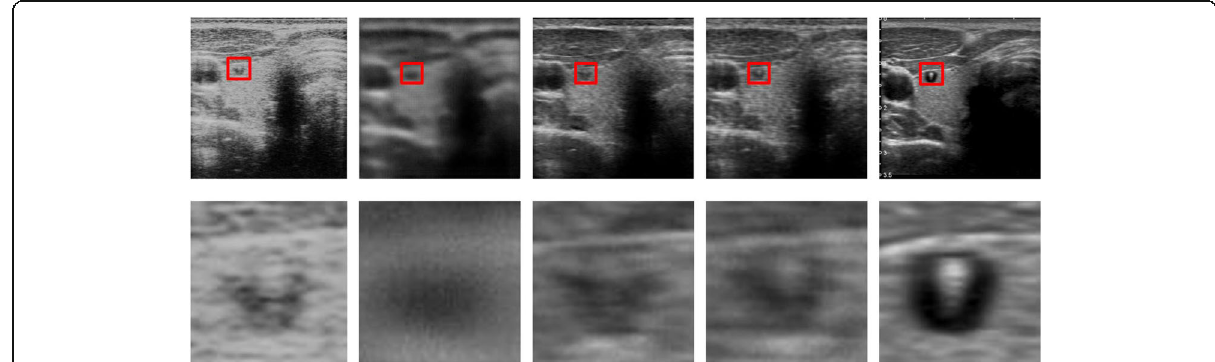
Fig. 8 Results of in vivo thyroid data. On the first line from left to right are low-quality image, encoder-decoder result, U-Net result, SSC U-Net result, and high-quality image correspondingly. The second line shows the image in the corresponding red box in the first line